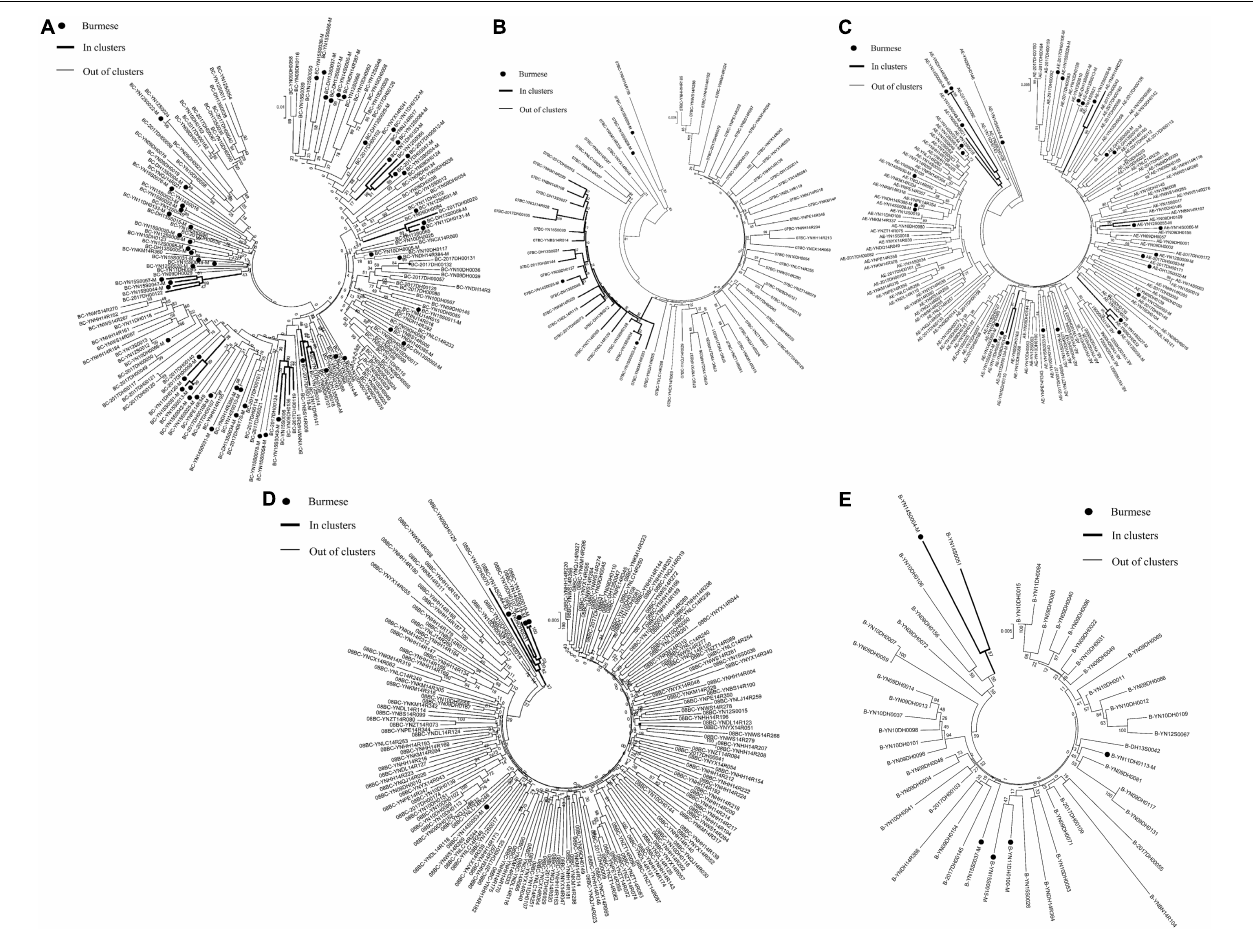
FIGURE 4 | Clustering of HIV-1 sequences for other subtypes. The tree was constructed using MEGA 7.0 with 1,000 bootstrap replicates. Molecular transmission clusters (MTC) were defined as clusters with two or more sequences and the pairwise gene distance less than or equal to 0.03 with bootstrap values ≥ 80%. The scale bar indicates 0.5% nucleotide sequence divergence. The black nodes represent Burmese. The thick line indicates individuals in clusters. The thin line indicates individuals out of clusters. (A) , subtype BC; (B) , subtype CRF_07BC; (C) , subtype CRF_01AE; (D) , subtype CRF_08BC; (E) , subtype